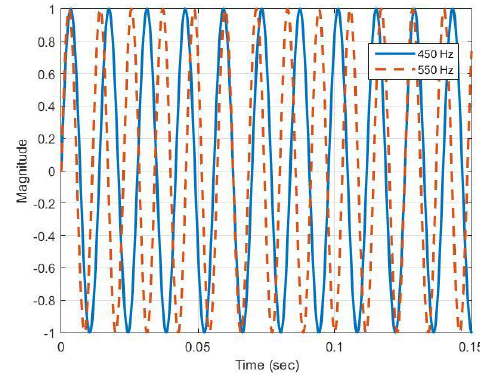
Figure A8. Sine wave frequencies, 450 – 550 Hz [2,4].